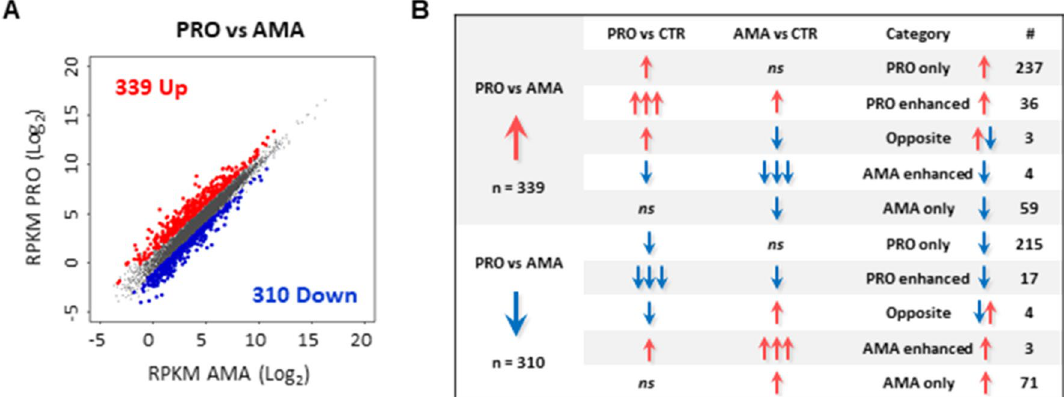
Figure 4. Parasite stage-driven changes in macrophage mRNA abundance during L. donovani infection. ( A ) Scatter plot of gene expression as RPKM (log 2 ) values for total mRNA between PRO and AMA datasets. Differentially regulated transcripts are indicated in red (upregulated) or blue (downregulated). Unchanged mRNAs are shown in grey. ( B ) Category distribution of transcripts differentially regulated in macrophages upon L. donovani PRO versus AMA